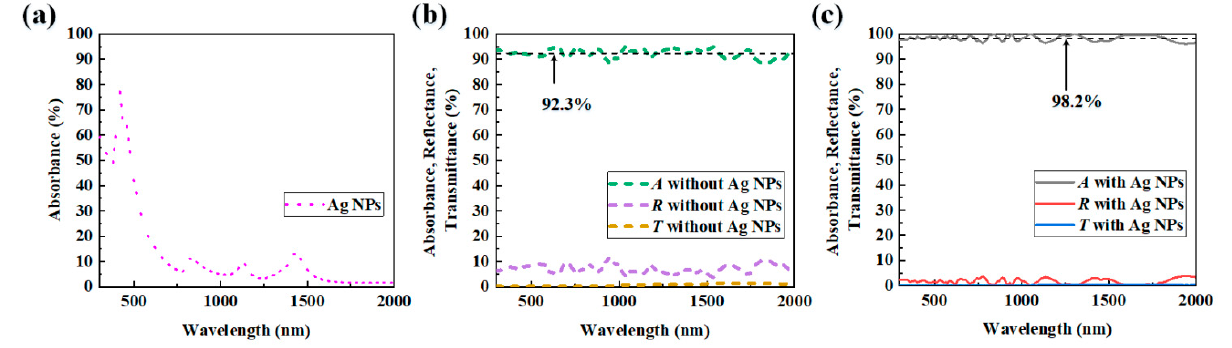
Figure 3. Simulated optical properties of ( a ) Ag NPs on Si substrate (before ICP process) and nanostructured Si metasurface ( b ) without and ( c ) with Ag NPs ( A -Absorbance, R -Reflectance, T -Transmittance, the black dotted line corresponding to the average absorbance).